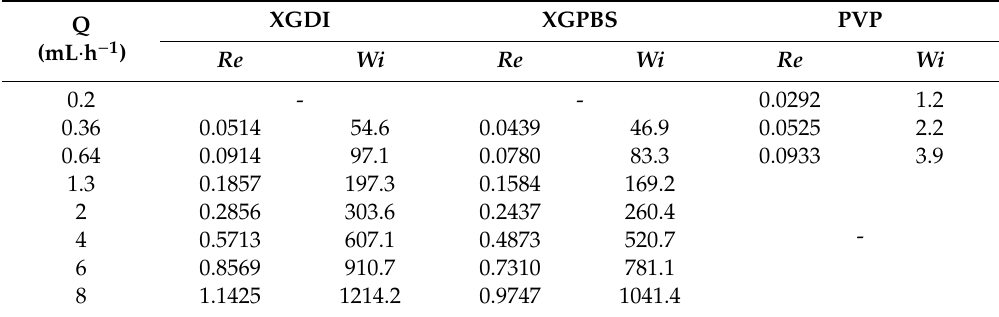
Table 2. Dimensionless groups of Reynolds ( Re ) and Weissenberg ( Wi ) numbers calculated based on the channel geometry and the flow rates considered in this work.